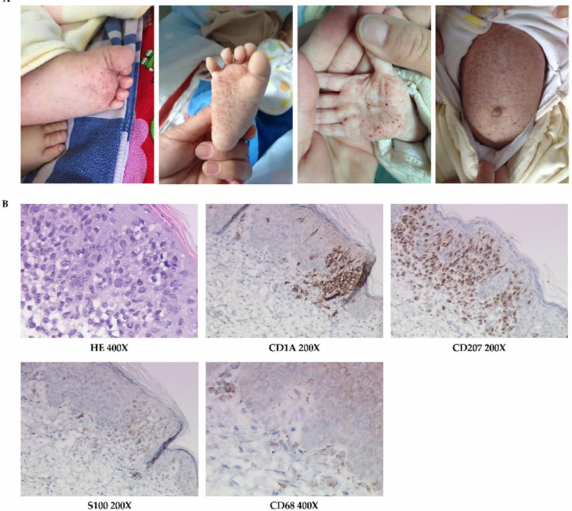
Figure 2. The skin manifestations and histopathology of patient 2. ( A ) Erythematous maculopapule, petechiae, ecchymosis, and crust, especially on trunk, palms, and soles. ( B ) HE-stained and immumo- histochemical staining for CD1A, CD207, S100, and